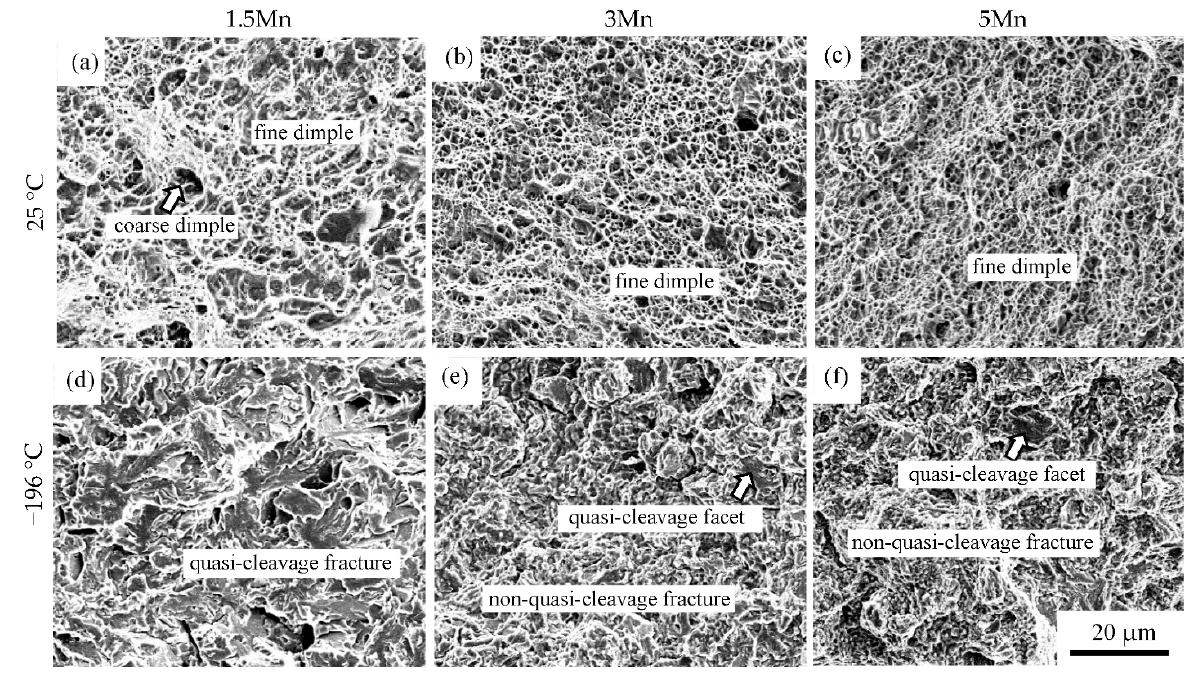
Figure 12. SEM images of fracture surface in the 1.5 Mn, 3 Mn, and 5 Mn steels subjected to the AC process after impact tests at ( a – c ) 25 °C and ( d – f ) −196 °C.